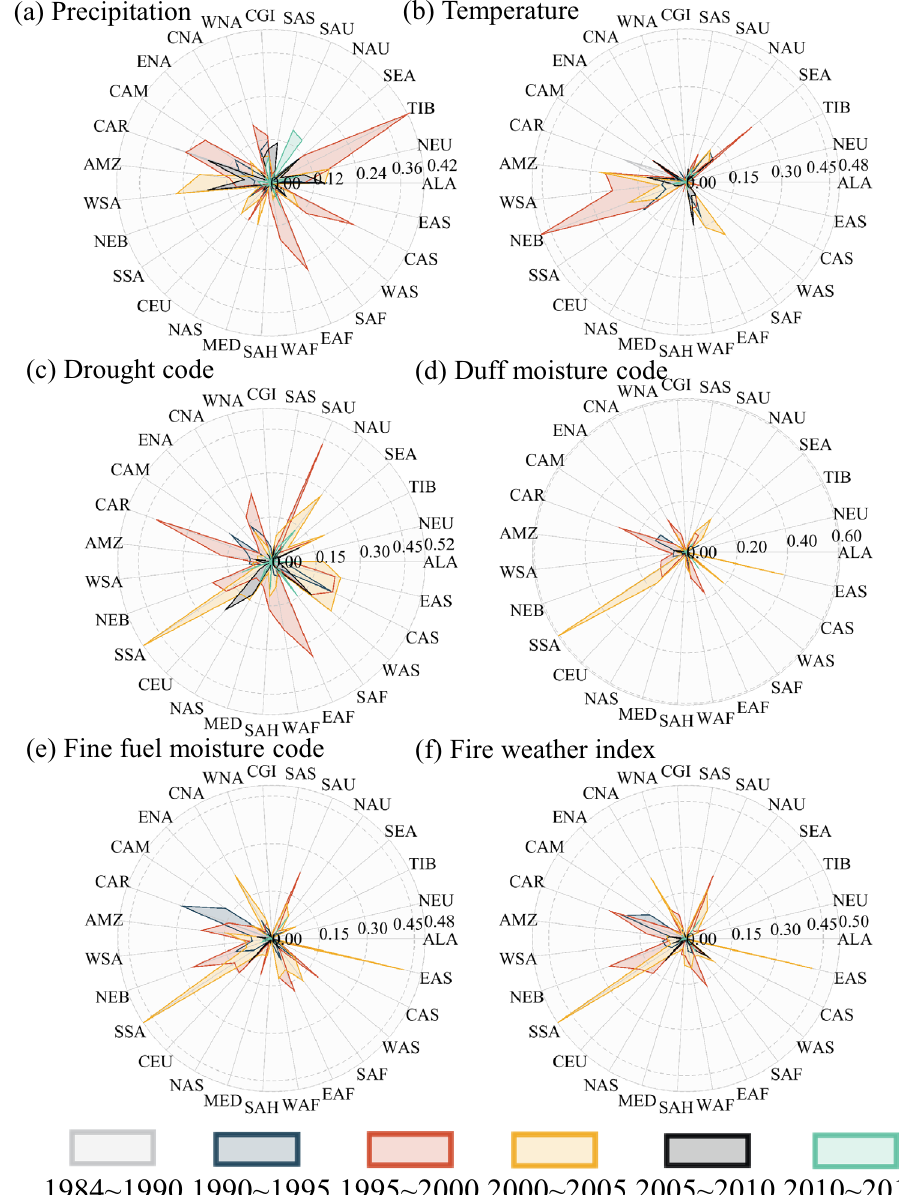
Fig. 6 Percentage of change-point dates in 27 climate reference regions. This figure shows the proportion of each change-point date in the 27 climate reference